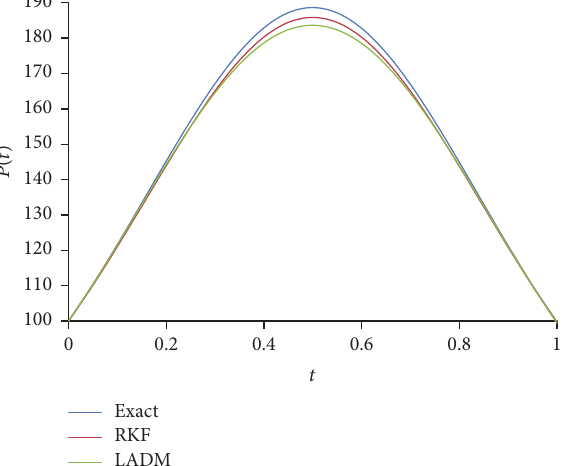
Figure 1: Comparison among the exact solution and the solutions obtained by using RKF method and LADM for model I.